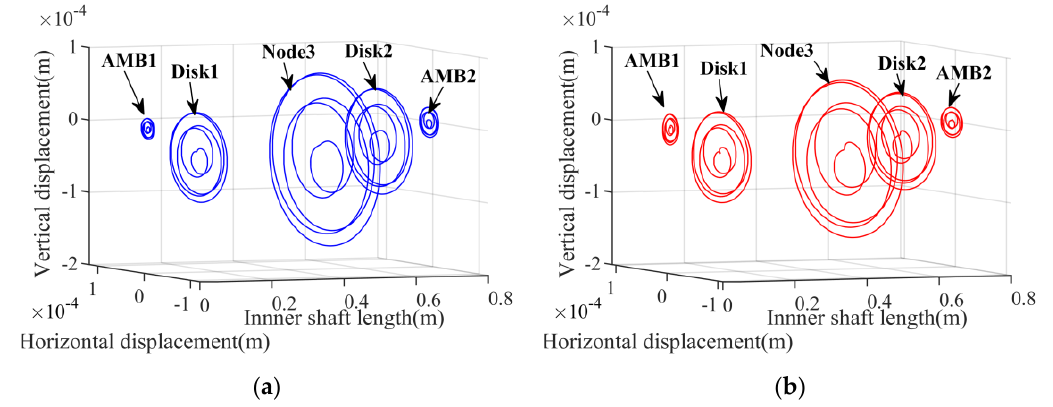
Figure 11. Shaft center trajectory diagrams of the inner rotor ( ω i = 200 rad/s; F L = 200 N). ( a ) The conventional MSDS, ( b ) the nonlinear MSDS.